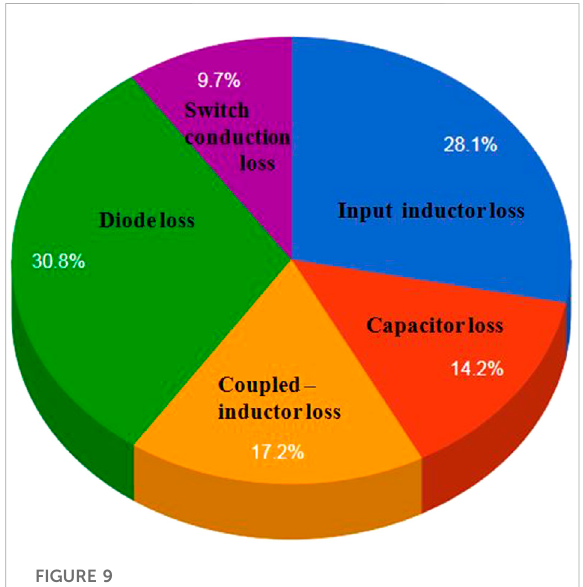
FIGURE 9 Proposed converter ’ s losses in various components.